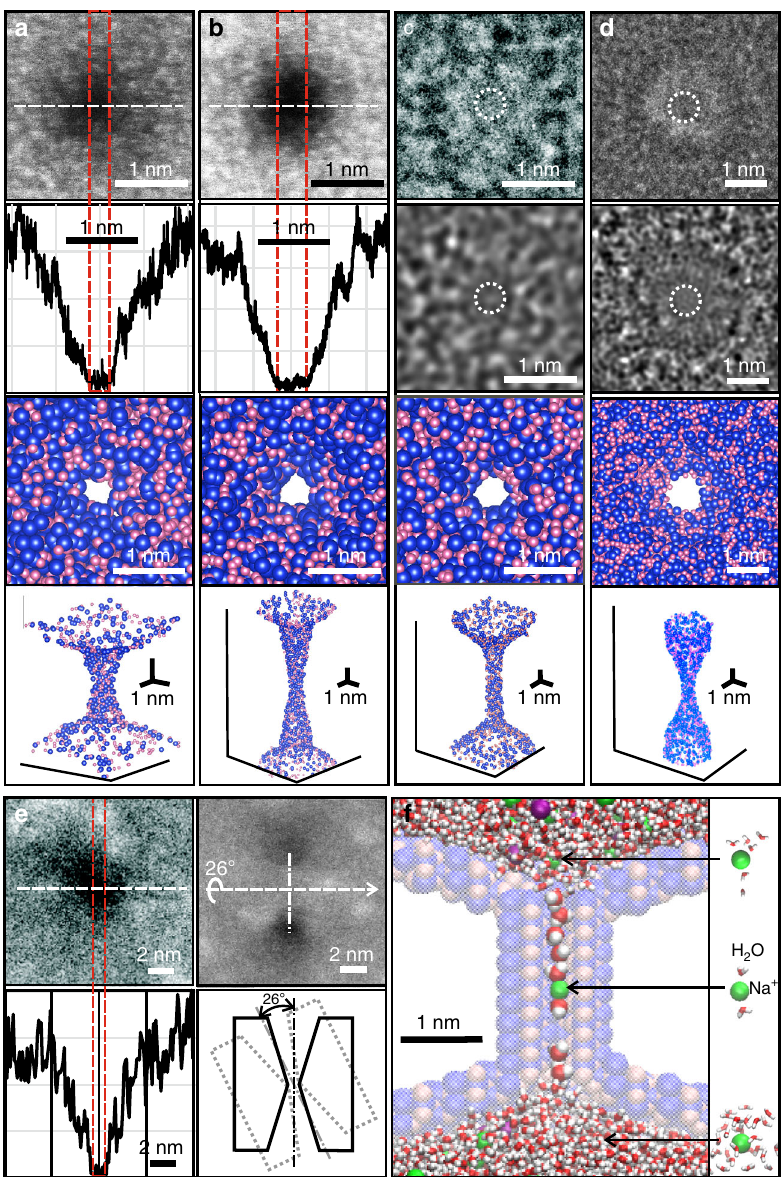
Fig. 1 Sub-nanopores sputtered through silicon nitride membranes. ( a , b ; top) HAADF-STEM images of two sub-nanopores with mean-diameters at the waist of 0.28 nm and 0.40 nm, respectively, acquired with an aberration-corrected Themis Z. ( a , b ; 2nd from top) Line-plots associated with the white dashed lines in (a, b top). The shot-noise between the red dashed lines indicates the pore diameter. ( a , b ; 2nd from bottom) 2D-projections from the top through models of the sub-nanopores in ( a , b ; top) that indicate the atomic distribution near the pore waist. The atoms are depicted by space- fi lling models in which each Si is represented by a blue sphere and each N is a pink sphere. ( a , b ; bottom) 3D-perspectives of the space- fi lled models ( a , b ; 2nd from bottom). ( c , d ; top) TEM images of two sub-nanopores with mean-diameters at the waist of 0.42 nm and 0.70 nm, respectively, acquired with the Titan. The dashed circles delineate the shot noise that de fi nes the pore waist. ( c , d ; 2nd from top) The corresponding multi-slice simulations of the TEM images ( c , d ; top) that were consistent with the imaging conditions. ( c , d ; 2nd from bottom) 2D-projections from the top through the models used in ( c , d ; 2nd from top) that indicate the atomic distribution near the pore waist. ( c , d ; bottom) 3D-perspectives of space- fi lled models of ( c , d ; 2nd from bottom). ( e ; top) HAADF-STEM images acquired from a pore with a mean-diameter of 0.89 nm at 0° (top, left) and 26° (top, right) tilt angles relative to the optic axis of the microscope. ( e ; bottom, left) The corresponding line-plot associated with the white dashed line ( e ; top) that indicates the mass-density under the beam. ( e ; bottom, right) An idealized model that illustrates the effect of the tilt angle on the image. f A snapshot extracted from MD of an idealized, negatively charged ( − 3 e ) 0.30 nm diameter sub-nanopore immersed in 1 M NaCl, illustrating the distortion of the hydration shell surrounding a Na + (green) as it permeates through the (ghost) pore. The Cl − (purple) are excluded from the pore because of de-hydration and electrostatic repulsion. Only the silicon (blue) and nitrogen (pink) atoms in the membrane at the pore surface are represented in the model, and even they are con fi nement the number of water molecules in the hydration a sub-nanopore also accomplished with MD. The PMF (red lines shell was lower than in the bulk. in Supplementary Fig. 4) was estimated by integrating the mean force acting on an ion along the pore axis z , and then decomposed The drastic change in the hydration shell in a sub-nanopore into ion-water (denoted as hydration, the blue line in Supple- doubtless affected the ion permeability. This assertion followed mentary Fig. 4) and ion-pore components (denoted as from calculations of the potential mean force (PMF) on an ion in